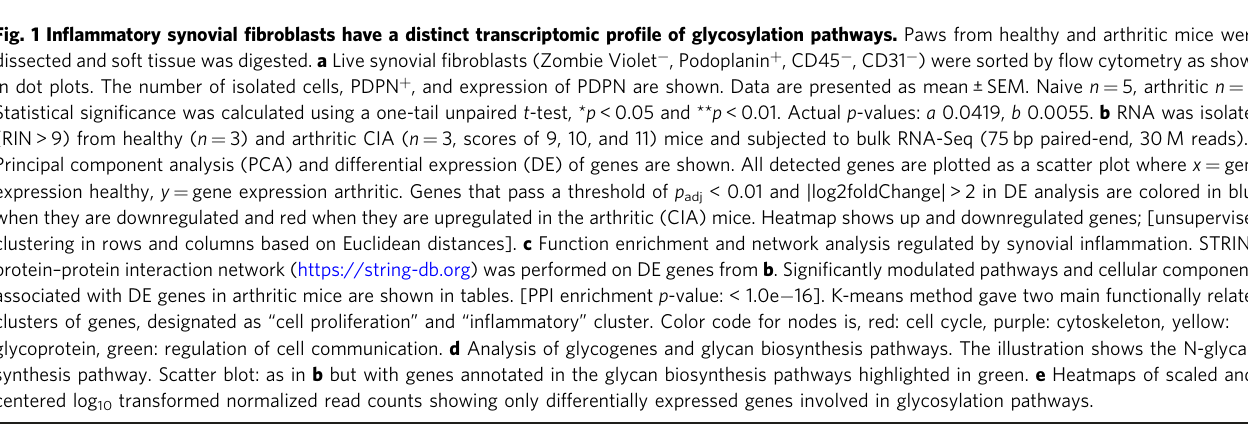
Fig. 1 In fl ammatory synovial fi broblasts have a distinct transcriptomic pro fi le of glycosylation pathways. Paws from healthy and arthritic mice were dissected and soft tissue was digested. a Live synovial fi broblasts (Zombie Violet − , Podoplanin + , CD45 − , CD31 − ) were sorted by fl ow cytometry as shown in dot plots. The number of isolated cells, PDPN + , and expression of PDPN are shown. Data are presented as mean ± SEM. Naive n = 5, arthritic n = 4. Statistical signi fi cance was calculated using a one-tail unpaired t -test, * p < 0.05 and ** p < 0.01. Actual p -values: a 0.0419, b 0.0055. b RNA was isolated (RIN > 9) from healthy ( n = 3) and arthritic CIA ( n = 3, scores of 9, 10, and 11) mice and subjected to bulk RNA-Seq (75 bp paired-end, 30 M reads). Principal component analysis (PCA) and differential expression (DE) of genes are shown. All detected genes are plotted as a scatter plot where x = gene expression healthy, y = gene expression arthritic. Genes that pass a threshold of p adj < 0.01 and |log2foldChange| > 2 in DE analysis are colored in blue when they are downregulated and red when they are upregulated in the arthritic (CIA) mice. Heatmap shows up and downregulated genes;